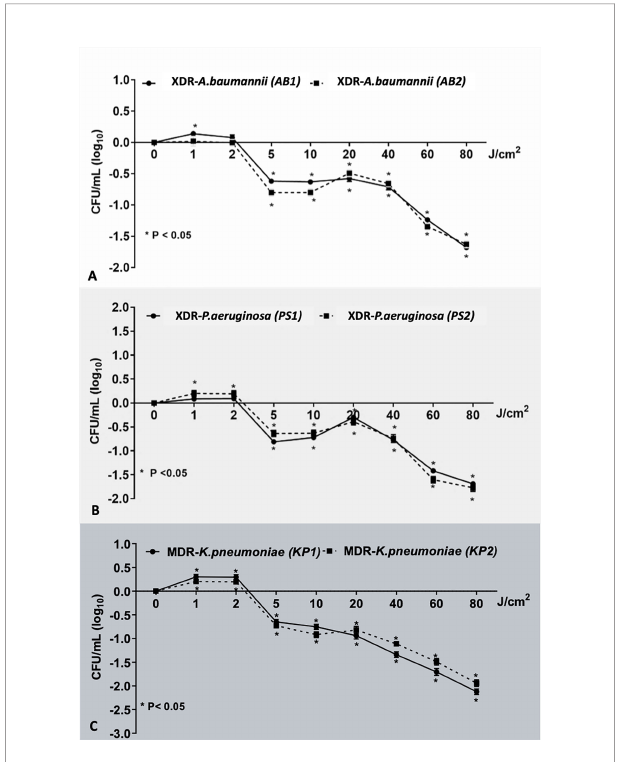
FIGURE 2 | The effect of various red light fl uence on each bacterial strain. This demonstrated the effect of red light on bacterial population: (A) XDR - AB1 and AB2, (B) XDR-PS1 and PS2, and (C) MDR-KP1 and KP2 in the dose-dependent manner. *Statistically signi fi cant difference (p-value <0.05).